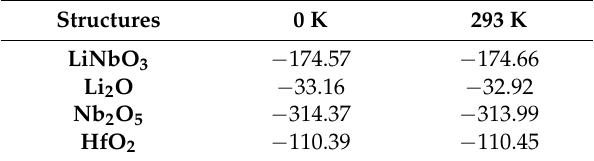
Table 5. Lattice energies used in the solution energy calculations (eV).